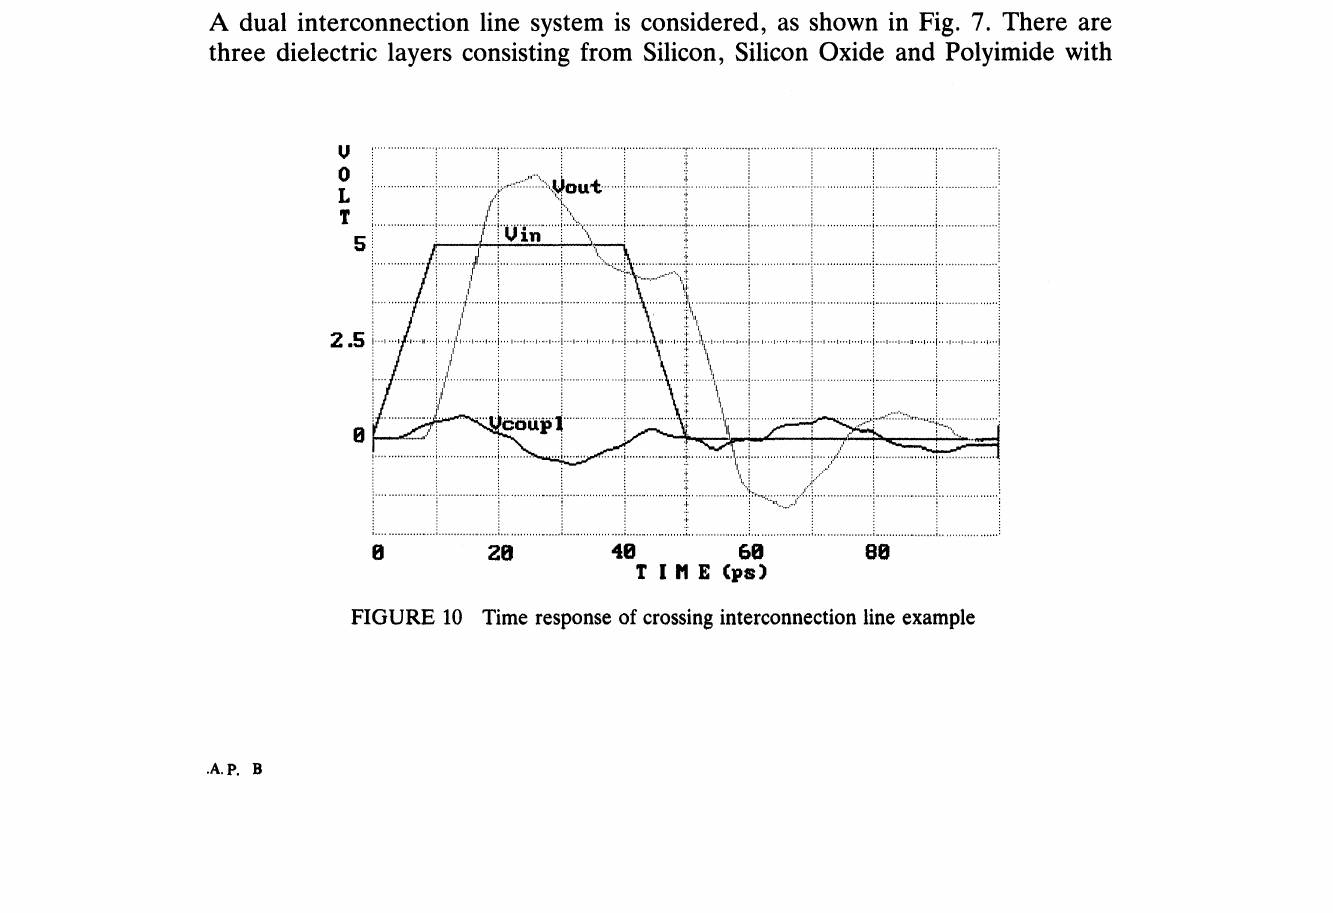
FIGURE 10 Time response of crossing interconnection line